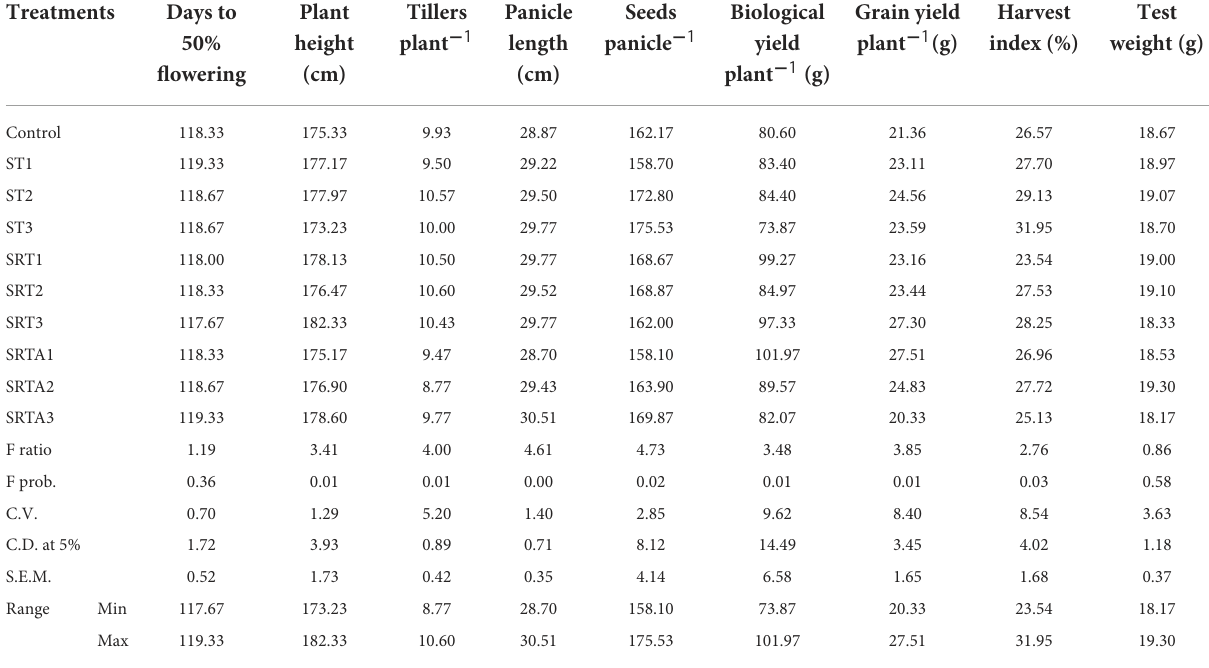
TABLE 2 Effect of calliterpenone on yield and yield contributing traits in rice.